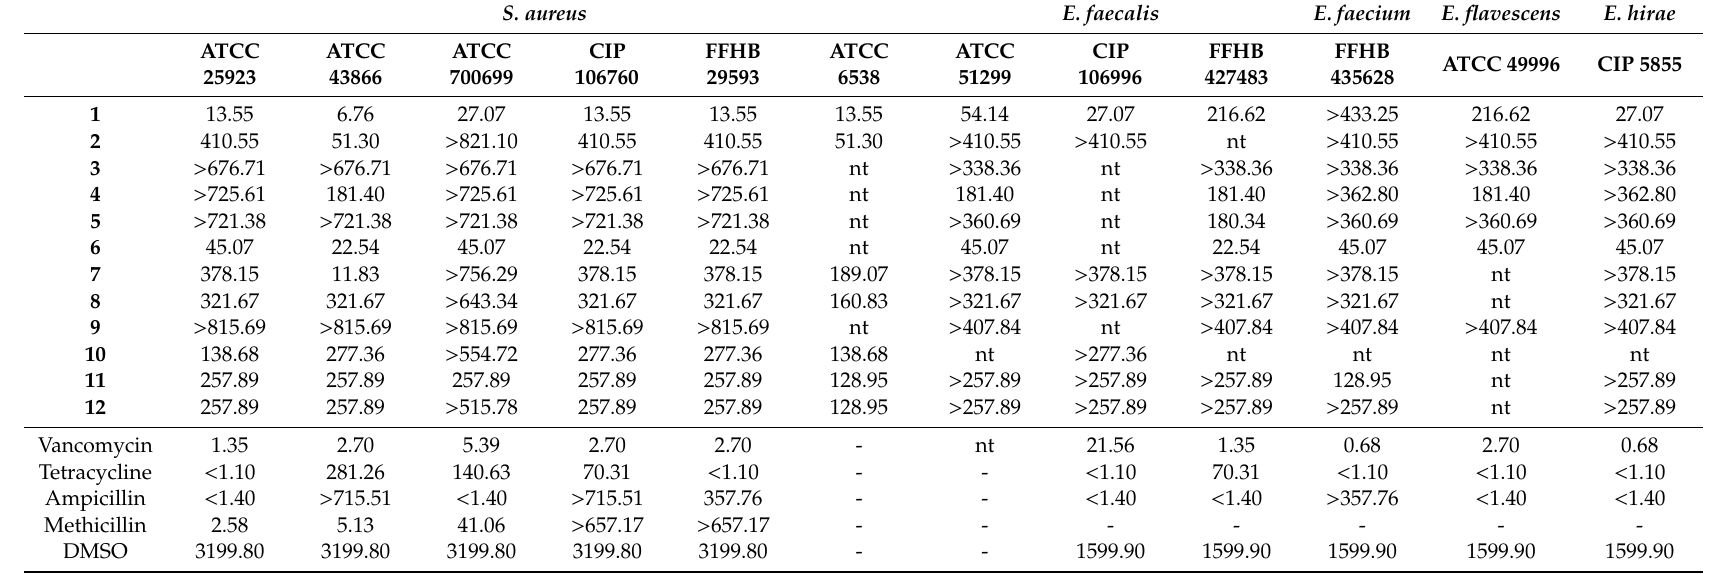
Table 1. MIC ( µ M) values of isopimaranes 1 – 12 against Staphylococcus aureus and Enterococcus